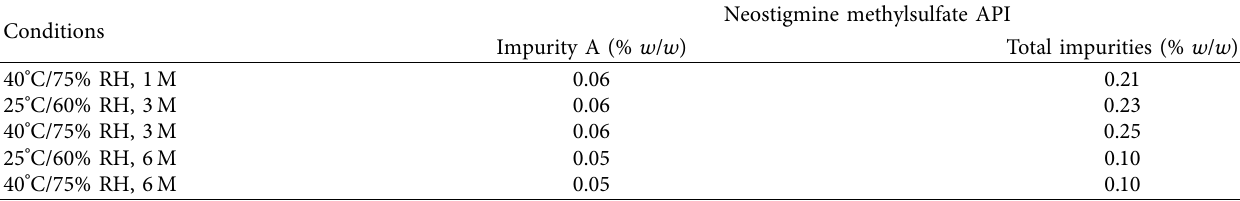
Table 9: Accelerated stability study data of NMS API.